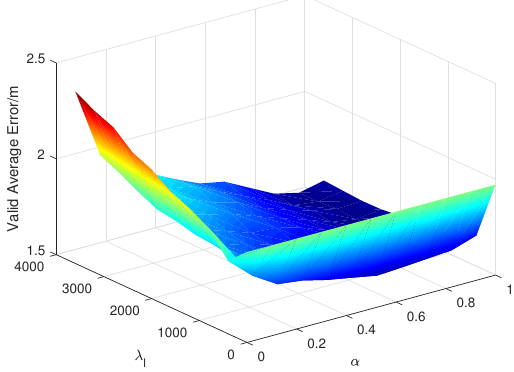
Figure 12. Validation error when taking different super-parameters in the 12th month